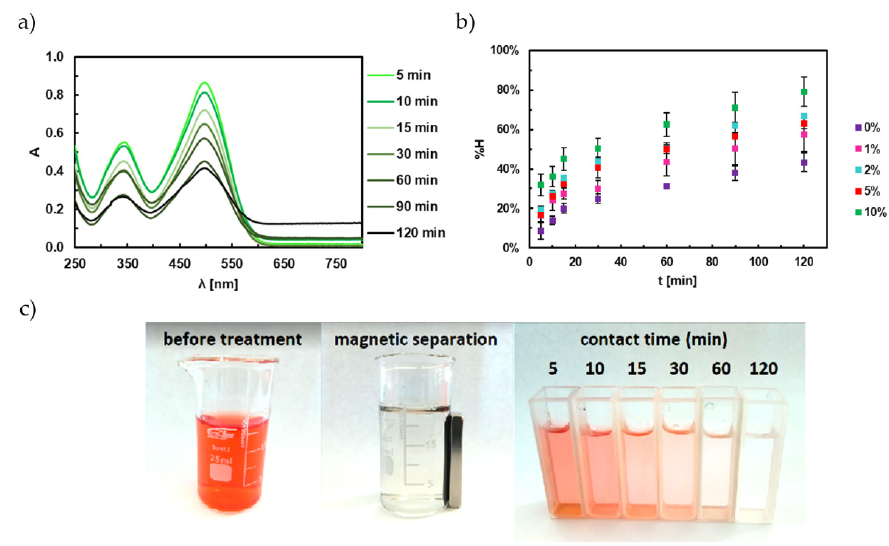
Figure 15. ( a ) UV-vis spectra adsorption of Congo red dye by Fe 3 O 4 @10%Zn nanoparticles with 20 mg adsorbent dose in function of contact time, ( b ) removal efficiency for 20 mg nanoparticles dose at 120 min, and ( c ) solution before and after treatment in pH 6.